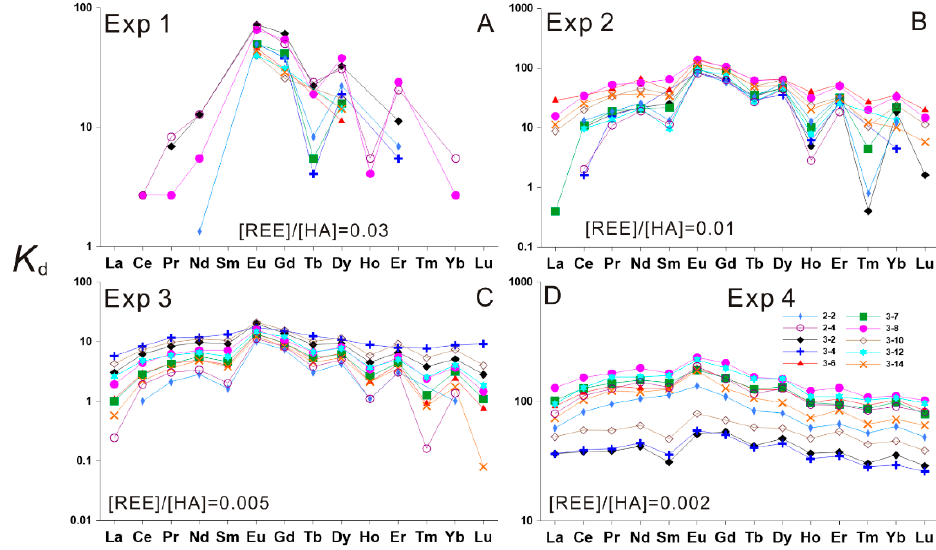
Figure 2. REE distribution pattern of K d obtained at 20 °C and various [REE]/[HA] ratios. ( A ), Experiment 1, performed at a [REE]/[HA] concentration ratio of 0.03 ([REE]/[HA] = 0.03); ( B ), Experiment 2, performed at [REE]/[HA] = 0.01; ( C ), Experiment 3, performed at [REE]/[HA] = 0.005; ( D ), Experiment 4, performed at [REE]/[HA] = 0.002 .